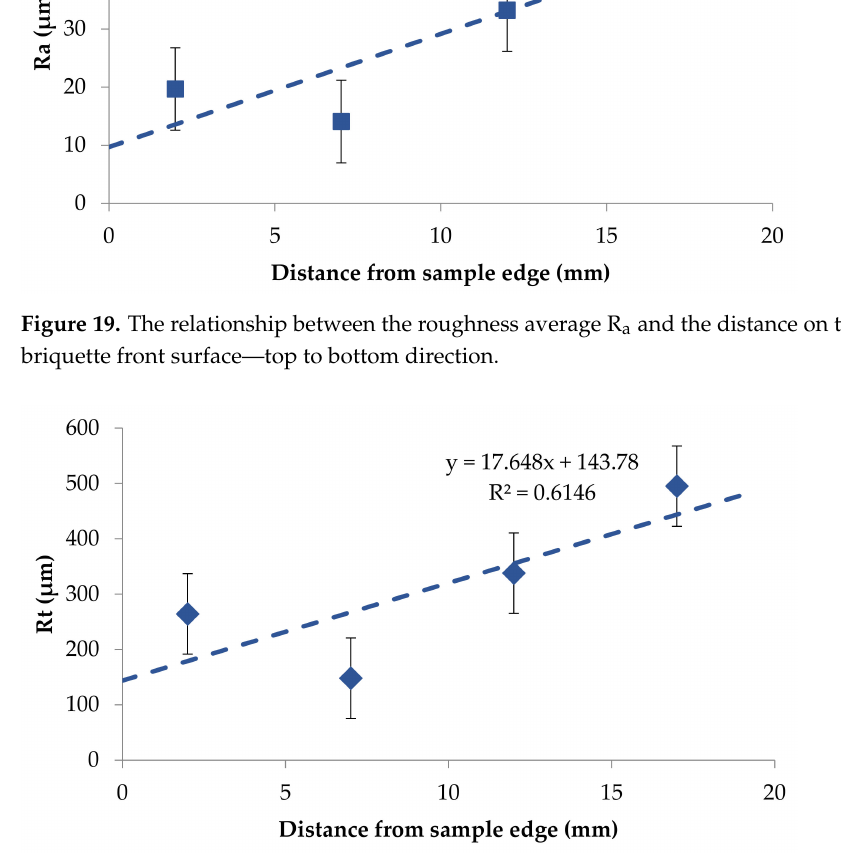
Figure 20. The relationship between the maximum height of the profile (R t ) and the distance on the edge on the briquette front surface—top to bottom